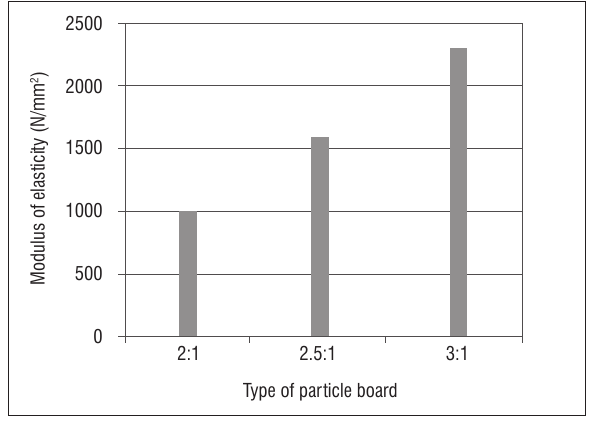
Figure 4: Modulus of elasticity of particle board produced using different adhesive–cassava stalk ratios (2:1, 2.5:1 and